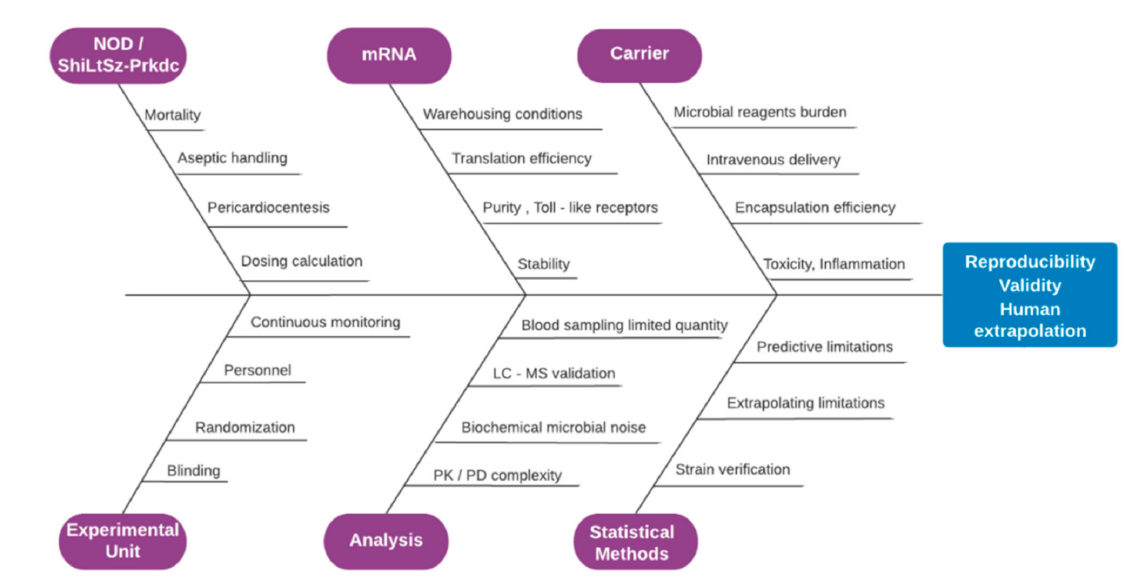
Figure 7. Fish bone diagram of risk assessment demonstrating the factors that critically alternate the validity of the obtained results and effect reproducibility and extrapolation, spanning the sectors of animal type, experimental unit preference, mRNA, analysis methods, carrier and statistical methods